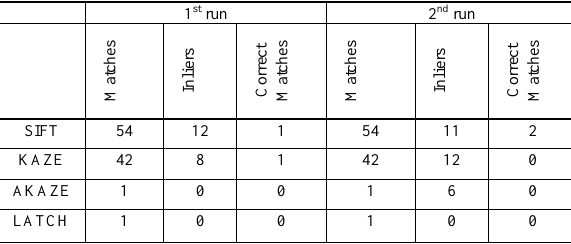
Table 4 Matching results of scene 2 between aerial and panoramic image of the 1st and 2nd iteration